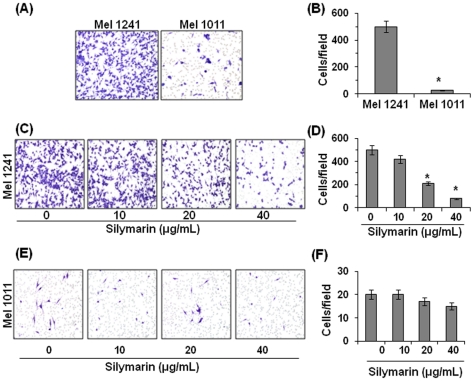
Silymarin inhibits human melanoma cell migration by targeting β-catenin.(A), Comparison of invasion ability of two different melanoma cell lines, one has stabilized mutation in β-catenin (Mel 1241) and another possesses wild-type β-catenin (Mel 1011). The migration capacity of Mel 1241 cells after 8 h is significantly higher than the migration capacity of Mel 1011 cells. (B) The migratory cells were counted under microscope and the results are summarized and expressed as the mean number of migratory cells ± SD per microscopic field. Significant difference versus Mel 1241 cells, *
P<0.001. (C), Treatment of Mel 1241 melanoma cells with silymarin for 8 h inhibits migration of Mel 1241 cells in a concentration dependent manner. (D) The migratory cells were counted under microscope and the results are summarized and expressed as the mean number of migratory cells ± SD/microscopic field (n = 3). Significant inhibition versus non-silymarin-treated control, *
P<0.001. (E) The effect of silymarin on the Mel 1011 melanoma cell migration after the treatment for 8 h. (F) The migratory cells were counted under microscope in different treatment groups and the results are summarized and expressed as the mean number of migratory cells ± SD/microscopic field (n = 3). Representative photomicrographs of cell migration are shown from three identical experiments.